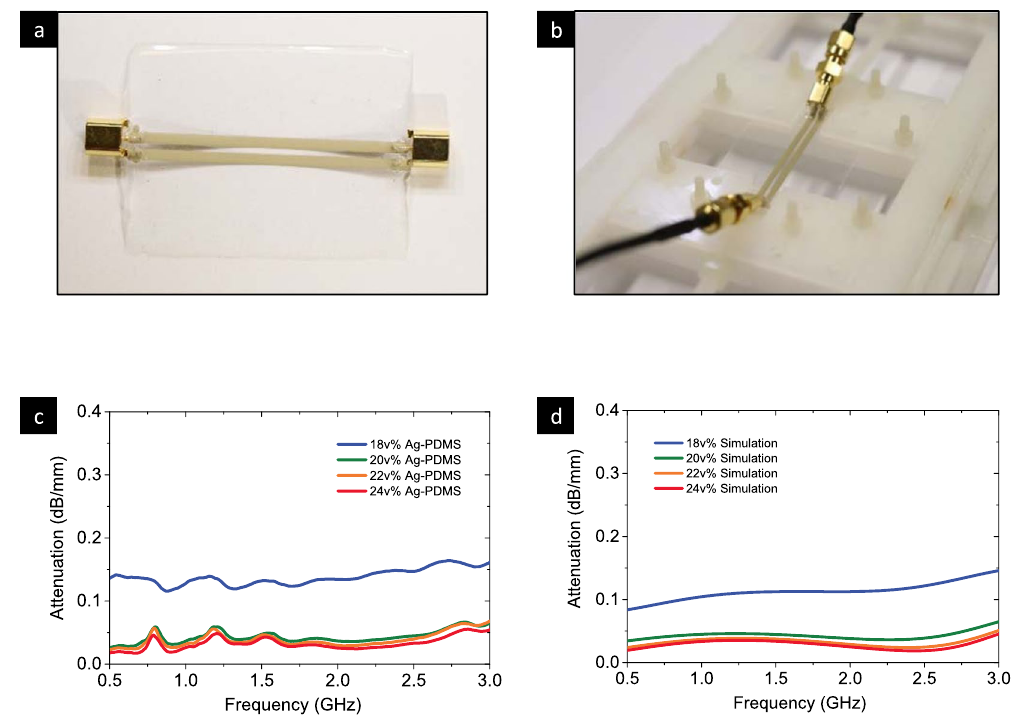
Figure 3. Performance of the transmission lines with different Ag-PDMS composites. ( a ) The outlook of Ag- PDMS transmission line with MCX adapters, ( b ) the tensile test fixture, ( c ) attenuation of the transmission line with different Ag volume fractions, and ( d ) the simulation of attenuation of the transmission